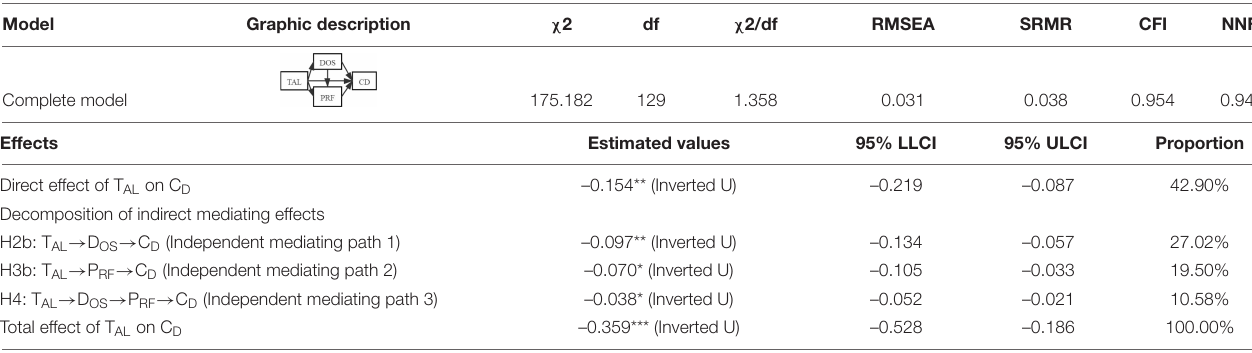
TABLE 6 | Model-Fit test and mediating effects